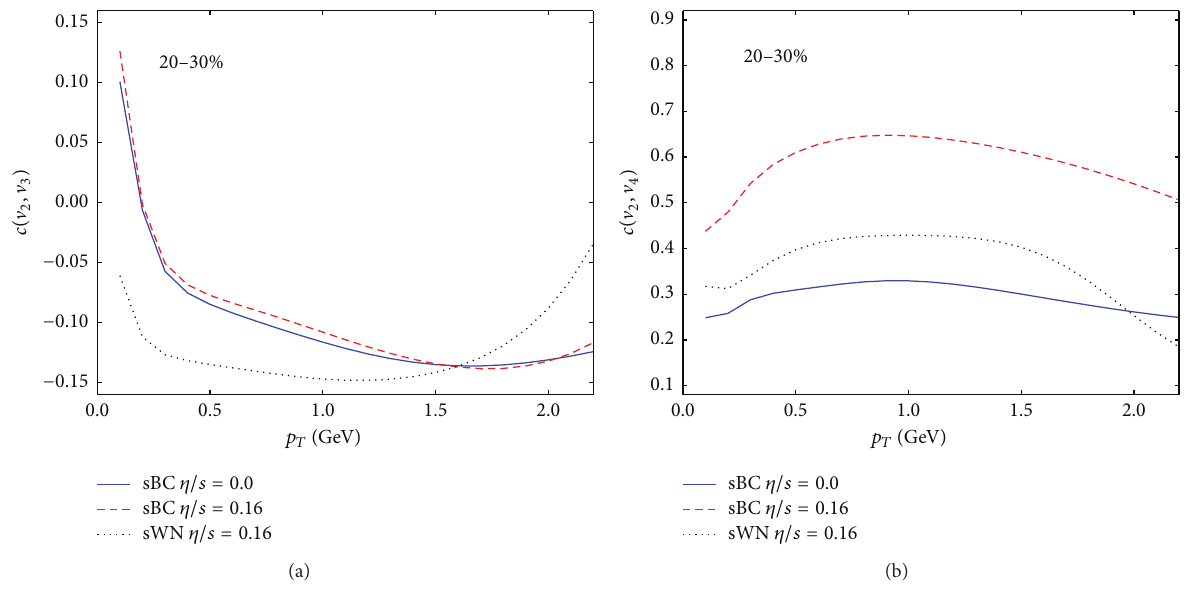
Figure 1: 𝑝 𝑇 dependence of 𝑐( V 2 , V 3 ) (a) and 𝑐( V 2 , V 4 ) (b) in centrality 20–30% in Pb–Pb collisions at √𝑠 NN = 2.76 TeV. Figures are taken from